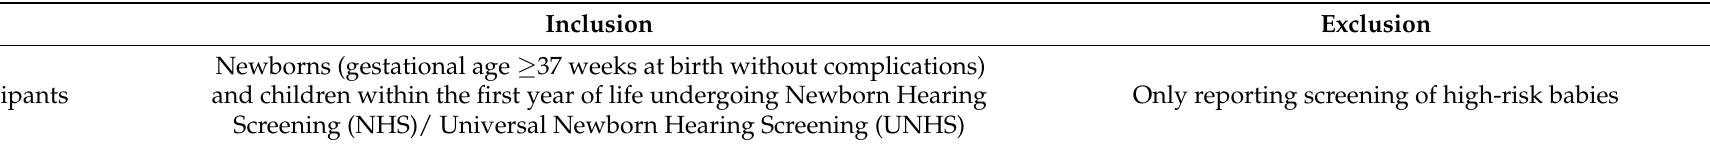
Table 2. Inclusion and exclusion criteria using the Population, Intervention, Control, Outcomes, Study design and Timeframe (PICOST)